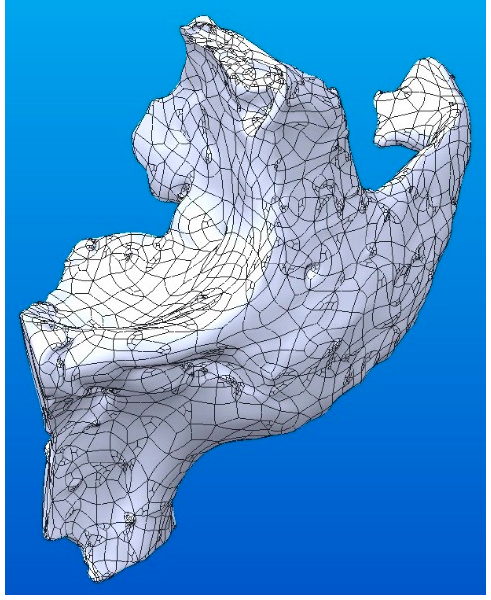
Figure 3. The 3D solid model resulted after conversion.